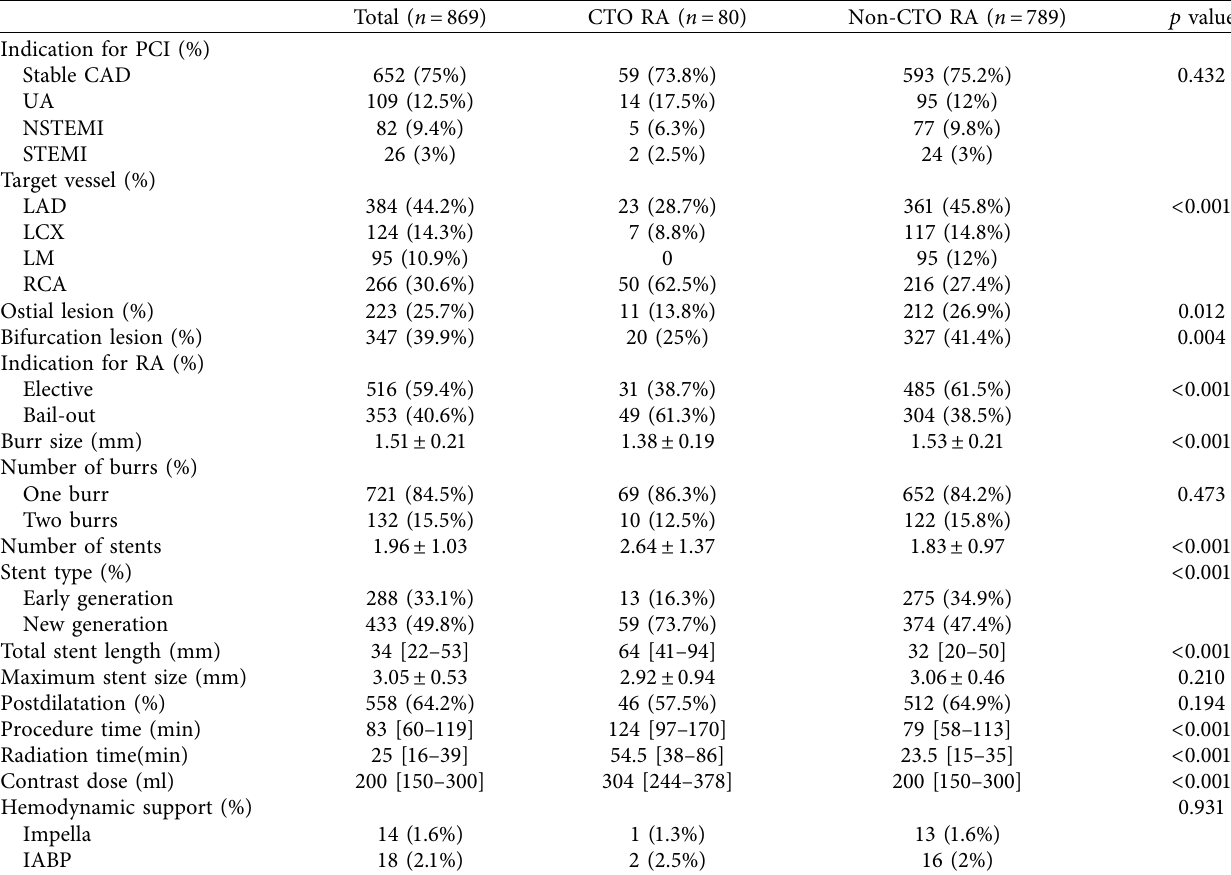
Table 2: Angiographic and procedural characteristics.